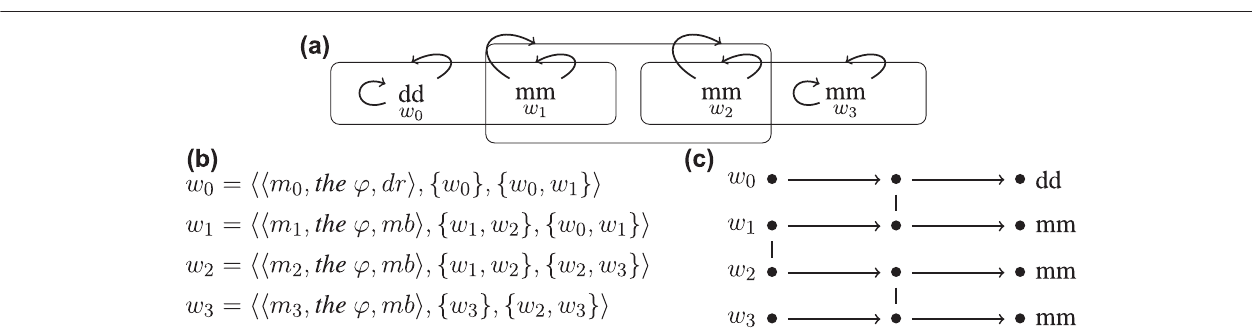
TABLE 7 | Representations of scenario